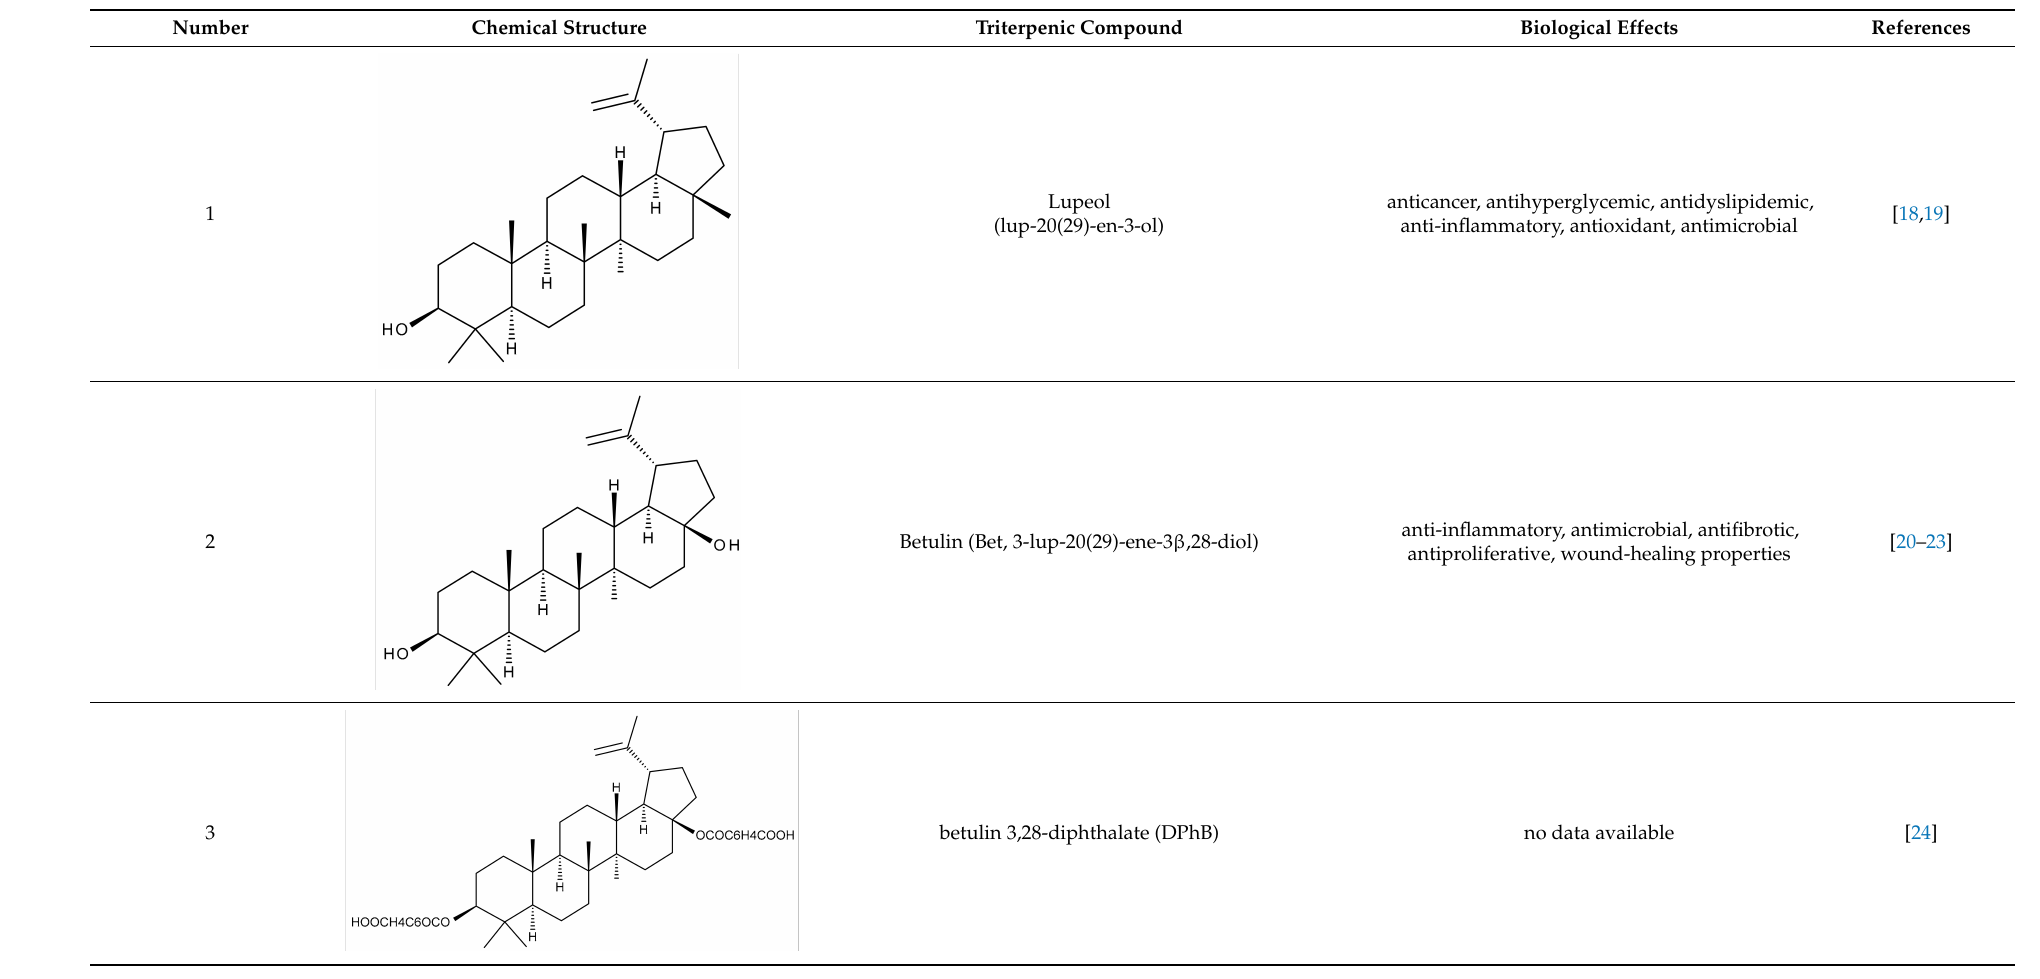
Table 1. Biological activities of triterpenic